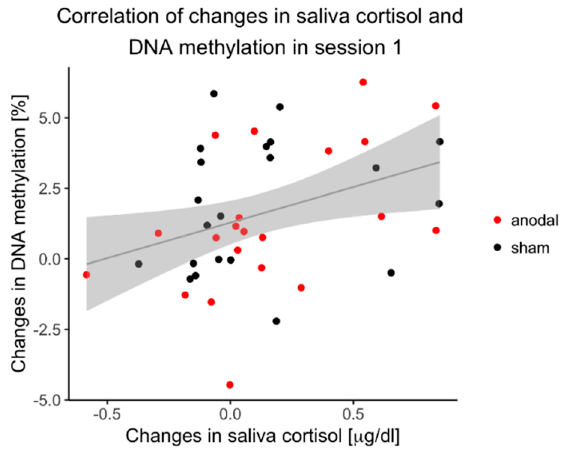
Figure 5. Correlation of DNAm changes and cortisol changes. Correlation of changes in DNAm during session 1 with changes in saliva cortisol concentration ( n = 42). Regression line with 0.95 confidence interval.